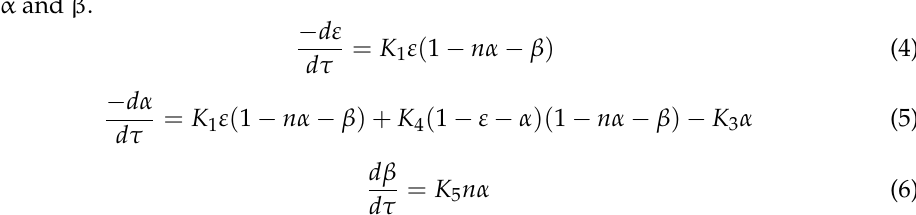
Table 2. Calculated overall rate constants K 1 – K 5 and molar ratio n for αE2 (concentration 200 μg/L).